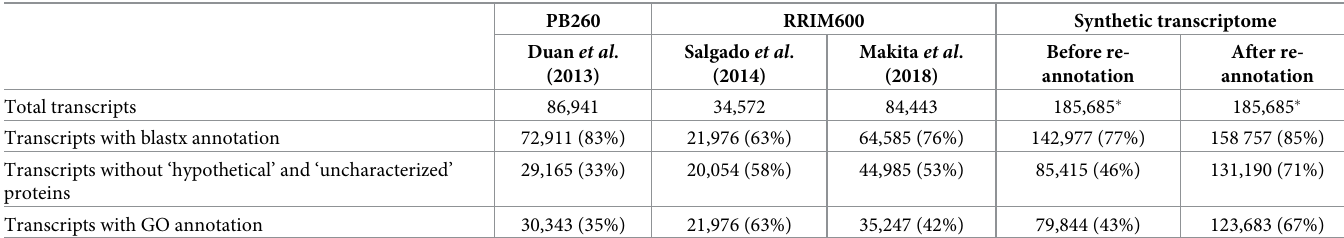
Table 2. Comparative metrics of functional annotations in published transcriptome references and our synthetic assembly.